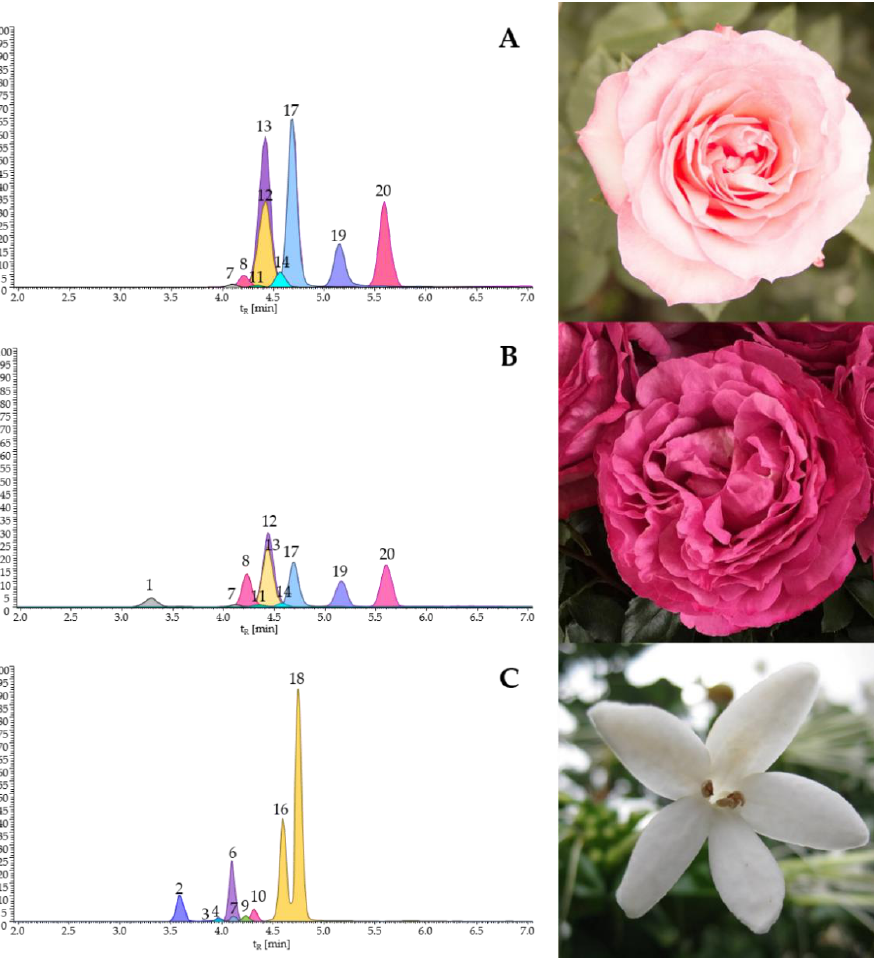
Figure 3. The extracted ionic currents (EICs) of [M] + or protonated molecules [M + H] + present in the total ion current (TIC) obtained by UHPLC – ESI+ – Orbitrap – MS for three flower extracts: ( A ) R. centifolia (pink variety), ( B ) R. centifolia (fuchsia variety), and ( C ) P. latifolia . The peak numbers correspond to major compounds as follows: 1 — Cyanidin-3,5-glucoside; 2 — Chlorogenic acid; 6 — Ecdysterone; 8 — Quercetin-glucoside; 10 — Rhamnetin-rutinoside; 12 — Quercetin-3-rhamnoside; 13 — Kaempferol-3-glucoside; 16 — cis- Resveratrol-diglucoside; 17 — Kaempferol-rhamnoside; 18 — trans- Resveratrol-diglucoside; 19 — Quercetin; 20 — Kaempferol.